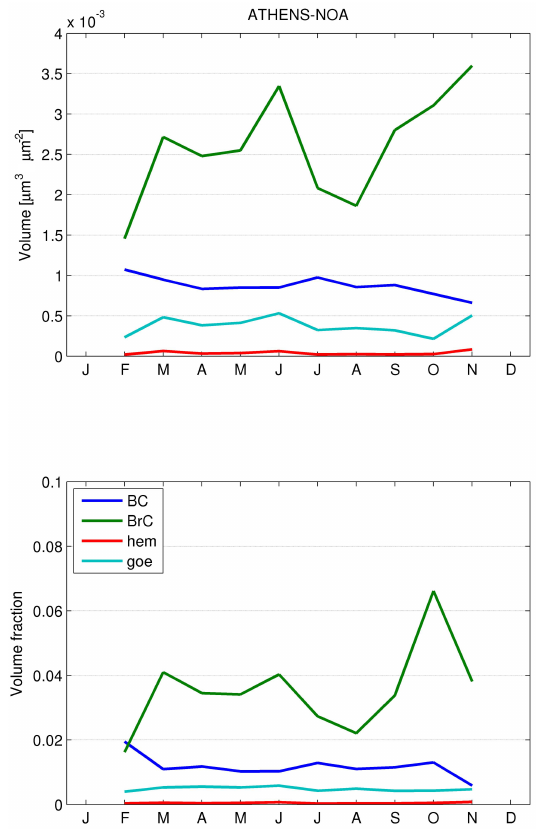
Figure 13. Total volume (in the upper plot) and volume fraction (in the lower plot) of absorbing aerosol components, as inferred from the method of Schuster et al. (2016). The retrieval gives the fractions for fine and coarse mode separately and here the contributions are shown as mode-weighted median value.